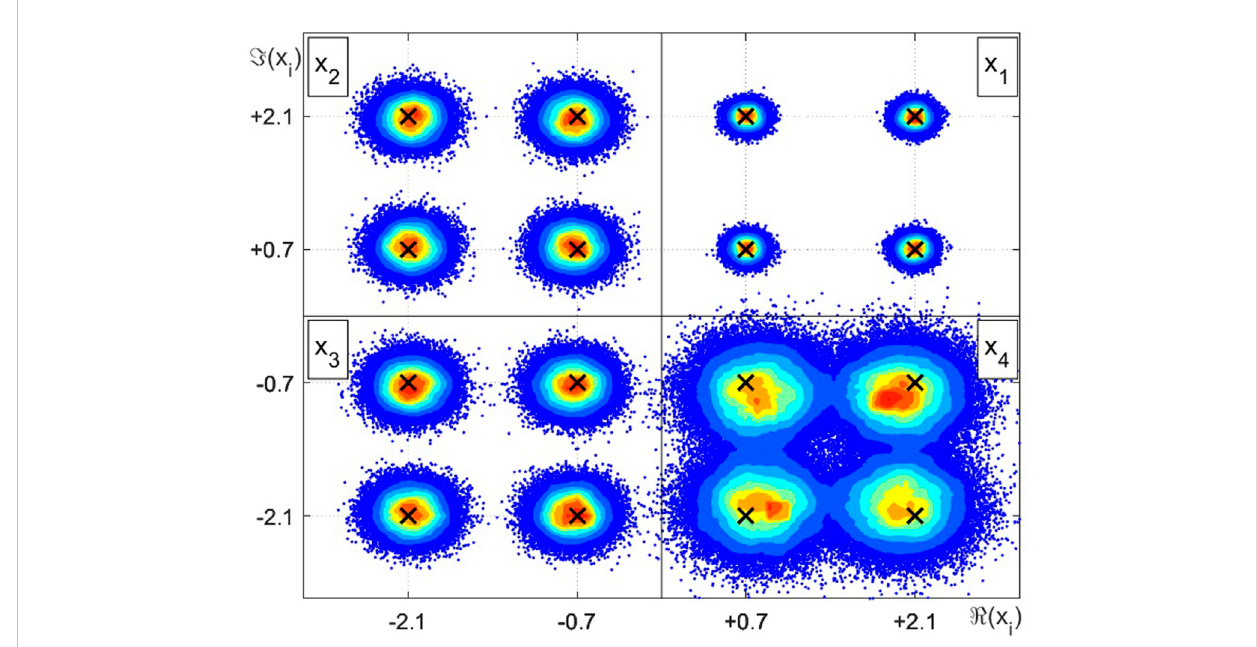
FIGURE 3 Intensity chart for the complex random variables estimation example employing LMMSE, STPD or MAP.